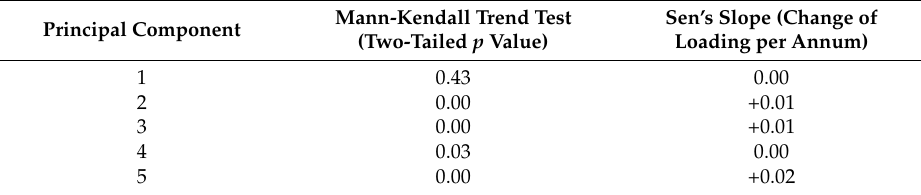
Table 2. Trend analysis of the time series of PC loadings at 5% level of significance.